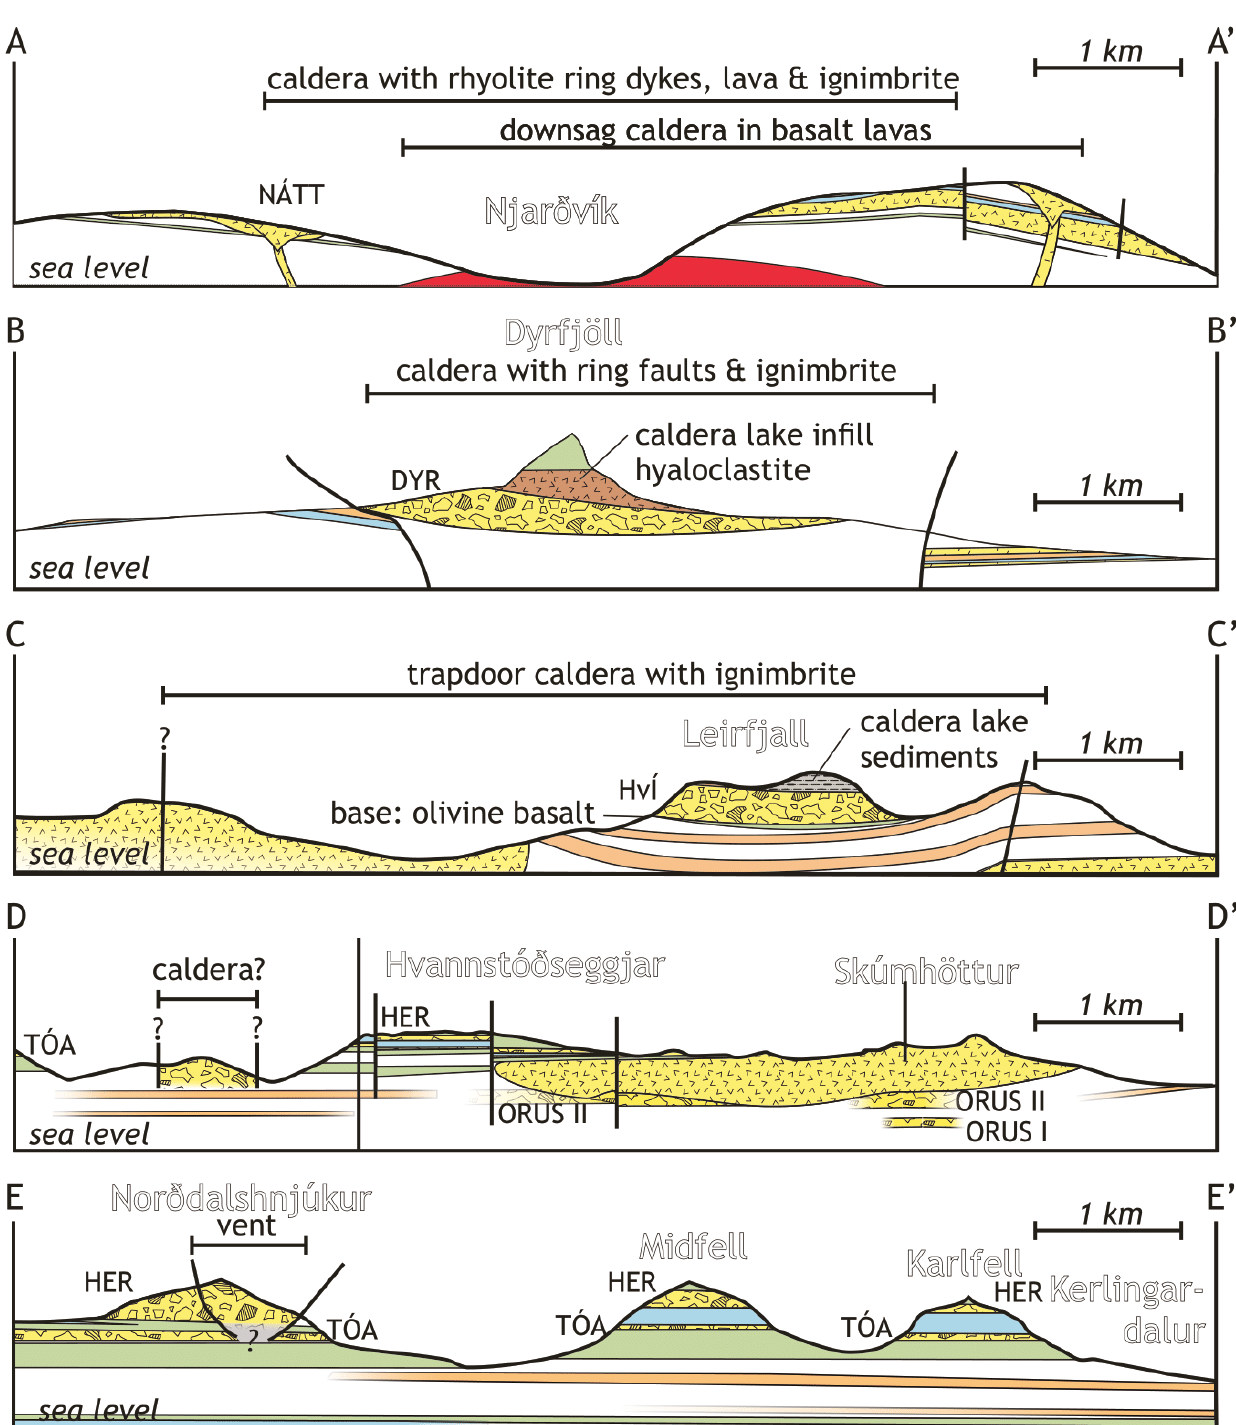
Figure 13: Cross sections through the collapse calderas and volcanic features associated with rhyolitic ignimbrites in the BEL area. For locations of cross sections and legend, see Figures 4, 7 and 9. Stratigraphic abbreviations from stratigraphic oldest to youngest: ORUS I = Orustukambur ignimbrite 1, ORUS II = Orustukambur ignimbrite 2, TÒA = Tóarhnjukur ignimbrite, HER = Herfell ignimbrite, HVÌ = Hvítserkur ignimbrite, DYR = Dyrfjöll ignimbrite. HER, HVÌ , and DYR have approximately the same age (ca. 12.4 Ma) [Berg 2016], the other ignimbrites are not